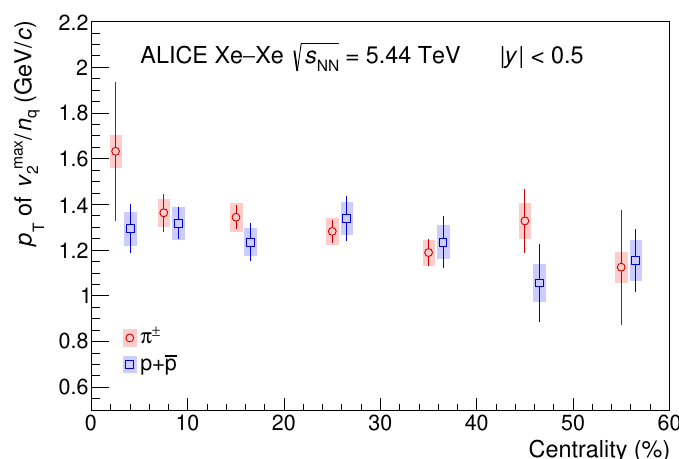
Figure 9. Centrality dependence of p T | v max for π ± and p+ p divided by number of constituent 2 quarks, n q . The p+ p points are slightly shifted along the horizontal axis for better visibility. Bars (boxes) denote statistical (systematic) uncertainties.